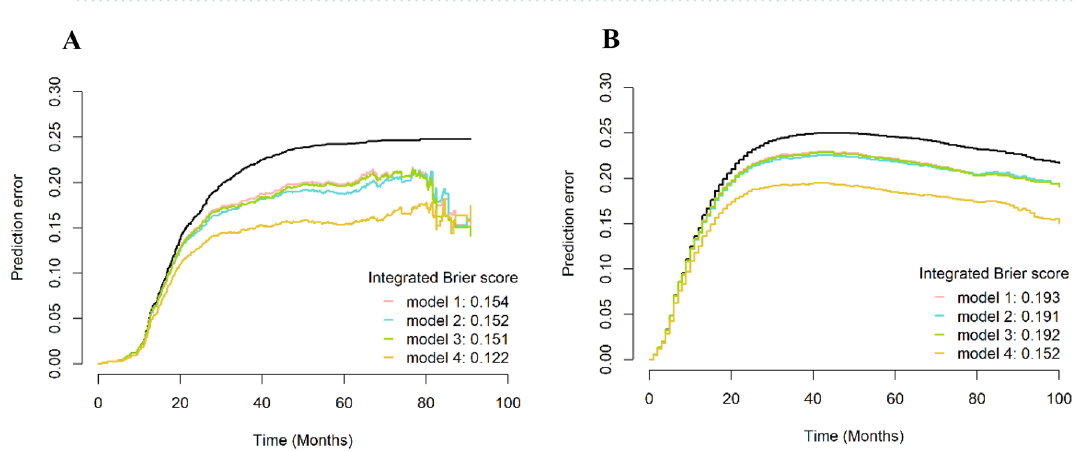
Figure 5. Prediction error curves of the prediction models. ( A ): Training cohort; ( B ): Testing cohort; model 1, Cox-TNM; model 2, Lasso-Cox; model 3, RSF-TNM; model 4,